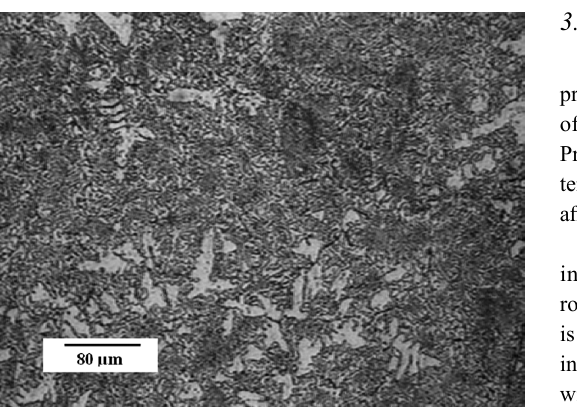
Figure 3. Micrograph of leaked material from Fig. 2c showing the presence of aluminium